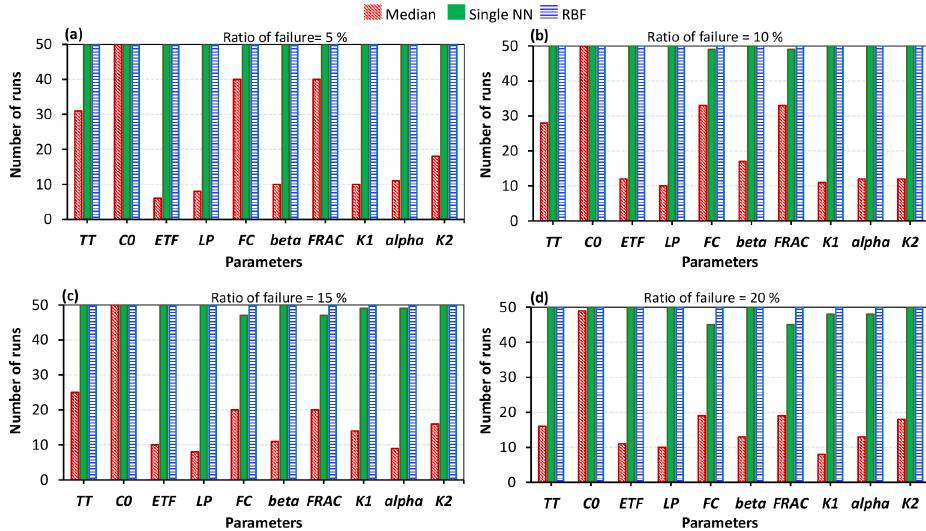
Figure 7. Comparison of the crash-handling strategies in estimating the parameter rankings for the HBV-SASK model using the STAR- VARS algorithm when the ratio of failure was (a) 5%, (b) 10%, (c) 15%, and (d) 20%. The y axis in each subplot shows the number of times out of 50 replicates that the rankings of the parameters were equal to the true